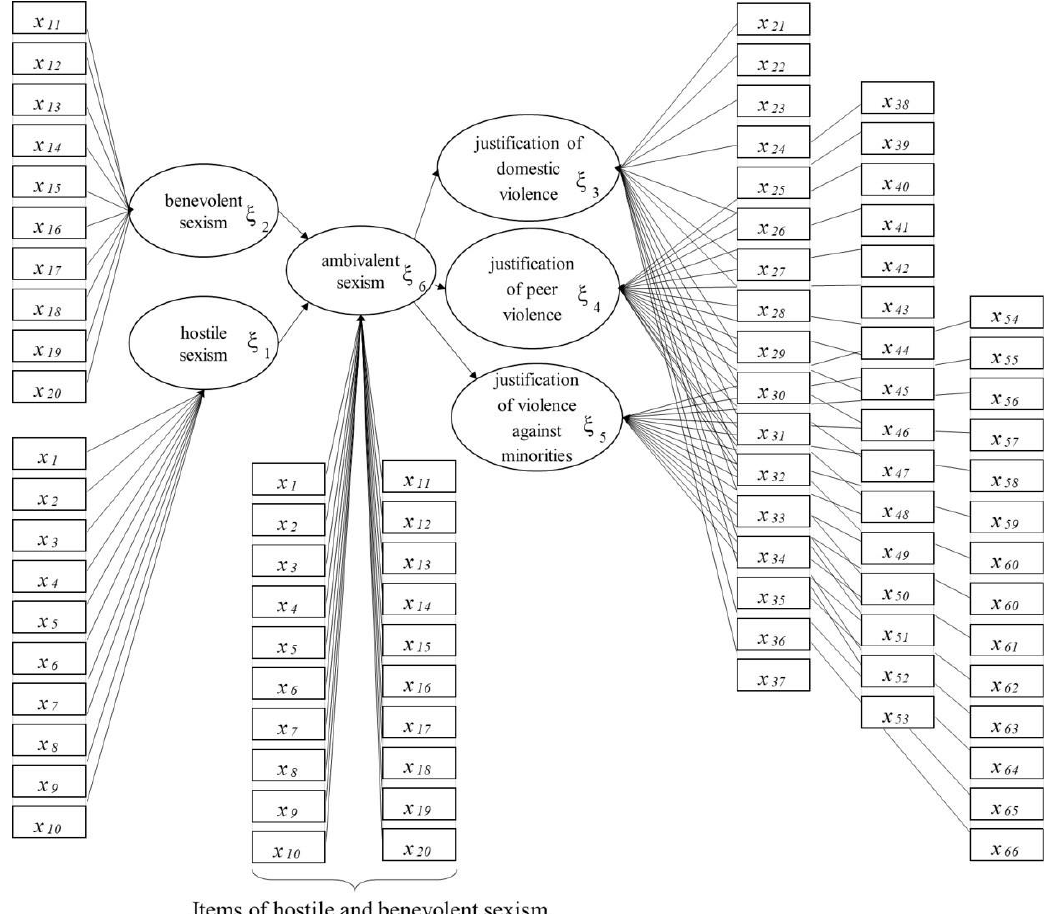
Figure 2. Structural and measurement model: the first step of the mixed two-step approach with the repeated MVs for the ambivalent sexism LVs.